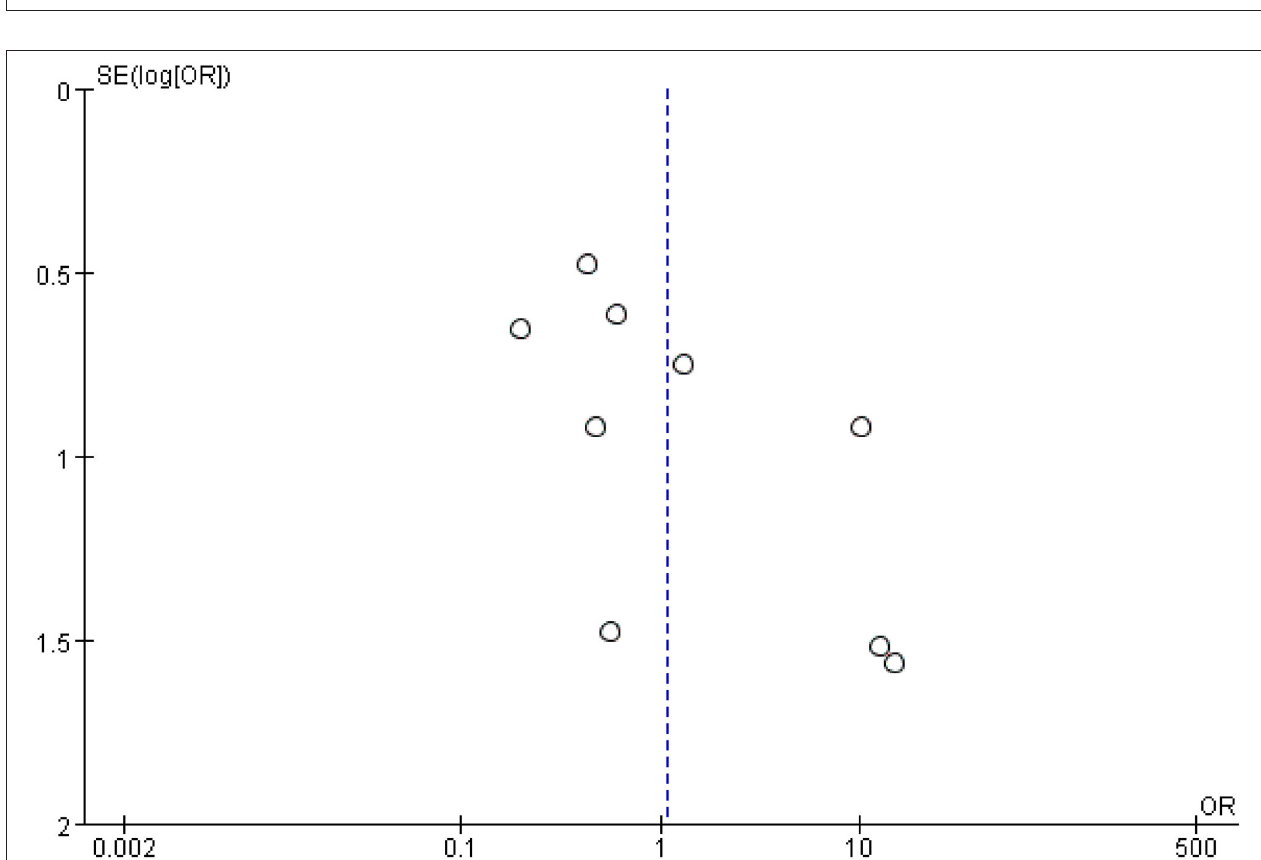
FIGURE 11 | Forest plot of late adverse events between EUS-CDS and EUS-HGS.